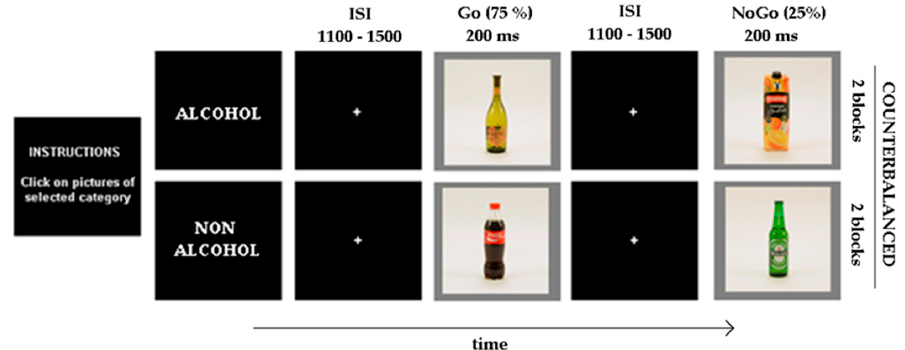
Figure 1. Beverage Go / NoGo task: Subjects were instructed to respond only to the Go stimuli (Alcoholic -Al- or nonalcoholic -NoAl- beverages according to the condition) by pressing the left-hand button of the mouse.